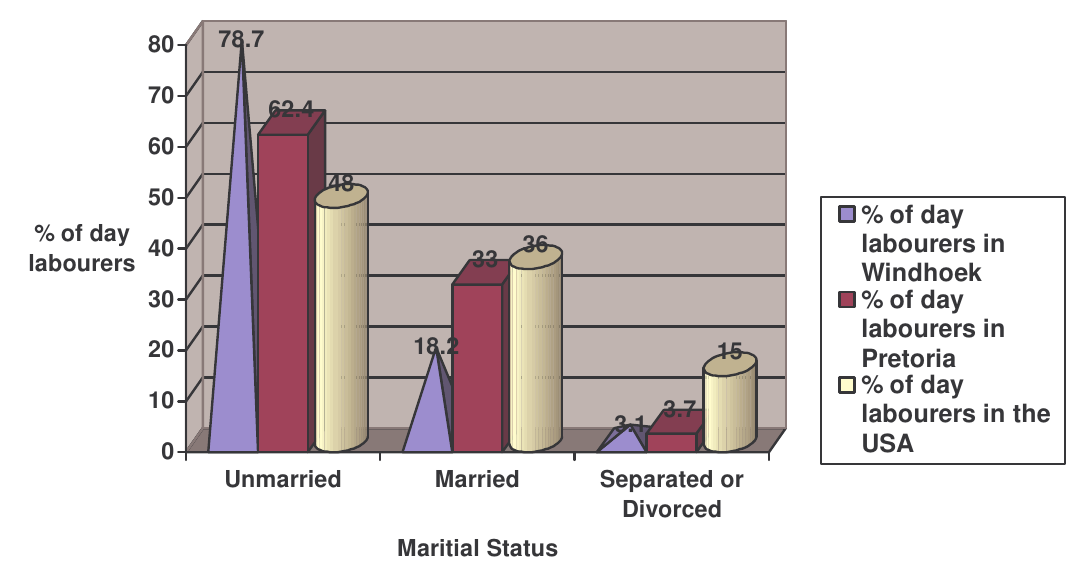
Figure 2: Day labourers’ marital status in Pretoria in 2004, Windhoek in 2003 & the USA in